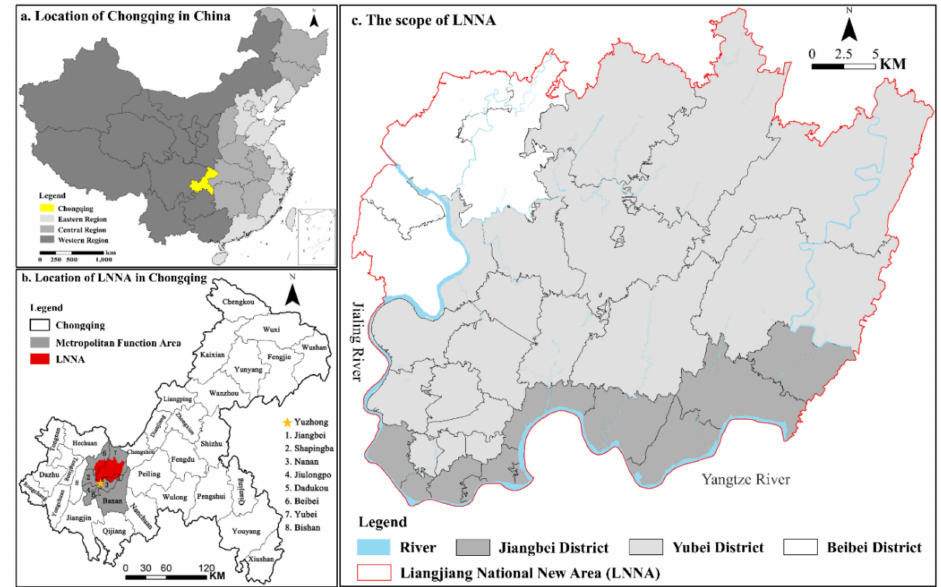
Figure 2. The location and administrative constitution of the LNNA (source: the